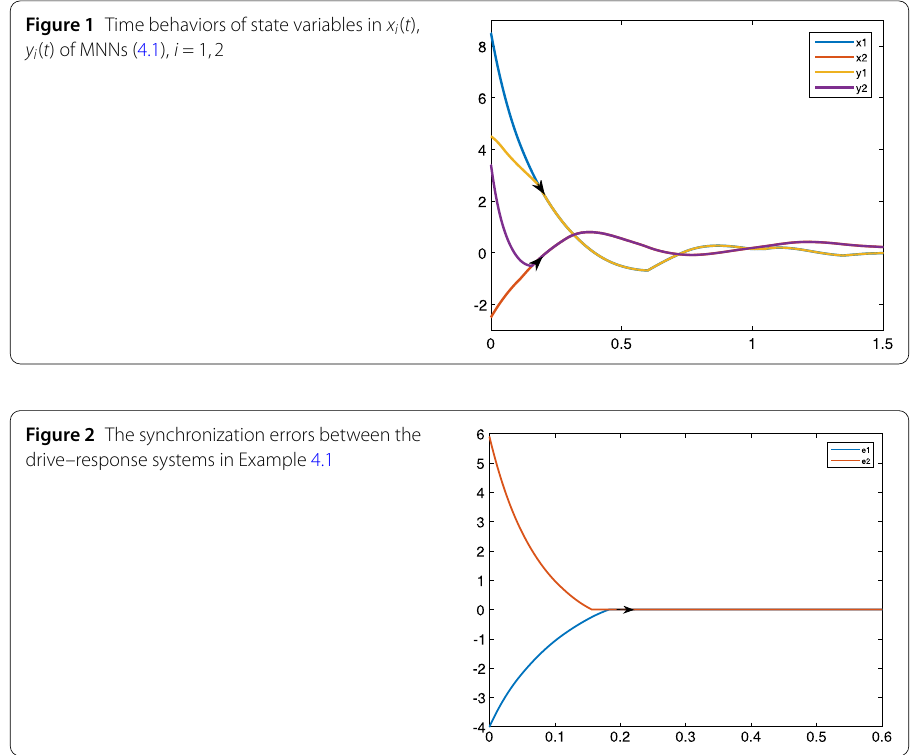
Figure 1 Time behaviors of state variables in x i ( t ), y